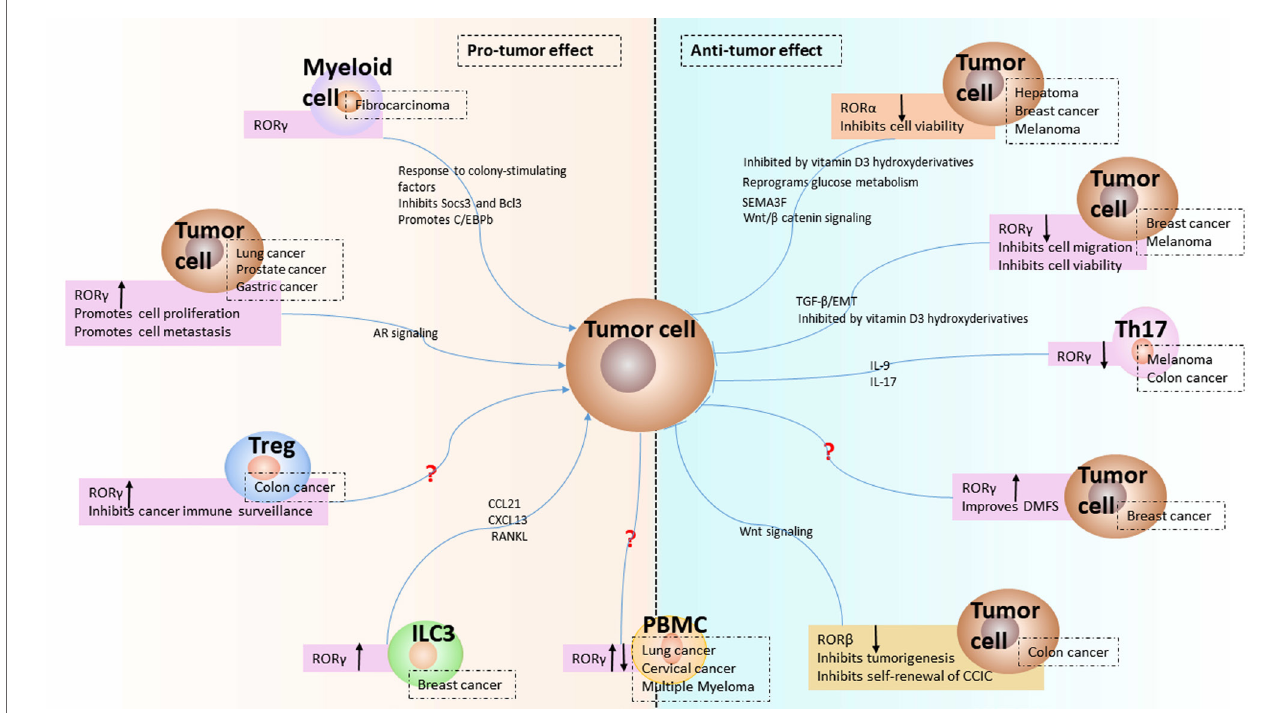
FiGURe 1 | Expression and function of receptor-related orphan receptors (RORs) in tumor microenvironment. The expression of ROR α and ROR β from tumor cell and the modulated expression of ROR γ in group 3 innate lymphoid cells (ILC3), Th17, regulatory T cell (Treg), myeloid cell, and tumor cell from tumor microenvironment are presented as reviewed in the text. The downregulation of ROR α and ROR β induce antitumor effect in hepatoma, breast cancer (BC), melanoma, and colon cancer. The upregulation of ROR γ in ILC3 leads to protumor effect by chemokines in BC. The downregulation of ROR γ in Th17 indicates antitumor effect by IL-17 in colon cancer. The upregulation of ROR γ in Treg shows protumor effect in colon cancer. The expression of ROR γ in myeloid cell has protumor effects via Socs3, Bcl3, and C/EBPb. The expression of ROR γ in tumor cell is either increased or decreased depending on the cancer type. Increased expression of ROR γ in lung cancer, prostate cancer, and gastric cancer results in protumor effect, while decreased expression of ROR γ in BC and melanoma could induce antitumor effect via TGF β /epithelial–mesenchymal transition (EMT) or vitamin D3 derivatives. The question mark refers to unknown mechanisms. The up or down black arrow refers to upregulation or downregulation. Antitumor: inhibits tumor progression; protumor: promotes tumor